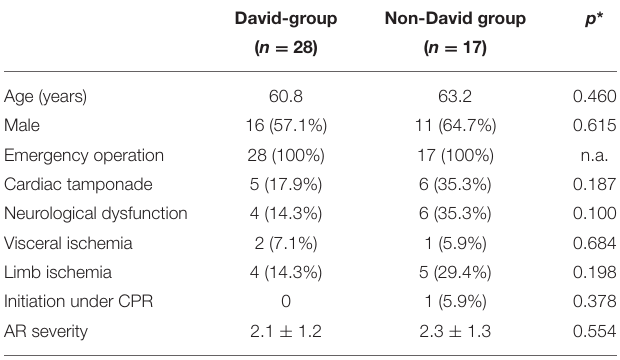
TABLE 1 | Patient characteristics. TABLE 2 | Intraoperative procedural